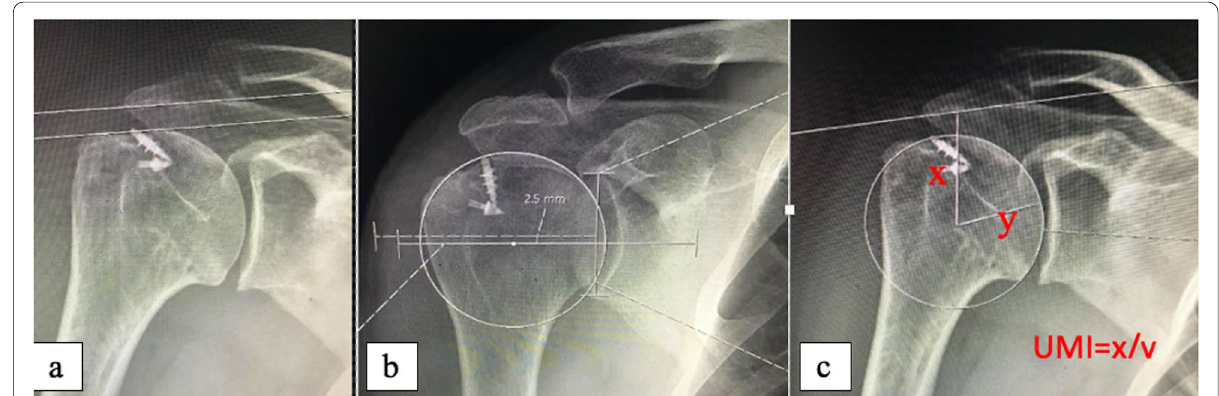
Fig. 2 Radiological measurements at X-ray. a Acromiohumeral distance measurements. b Humeral migration measurements, c Upper migration index formula and measurements